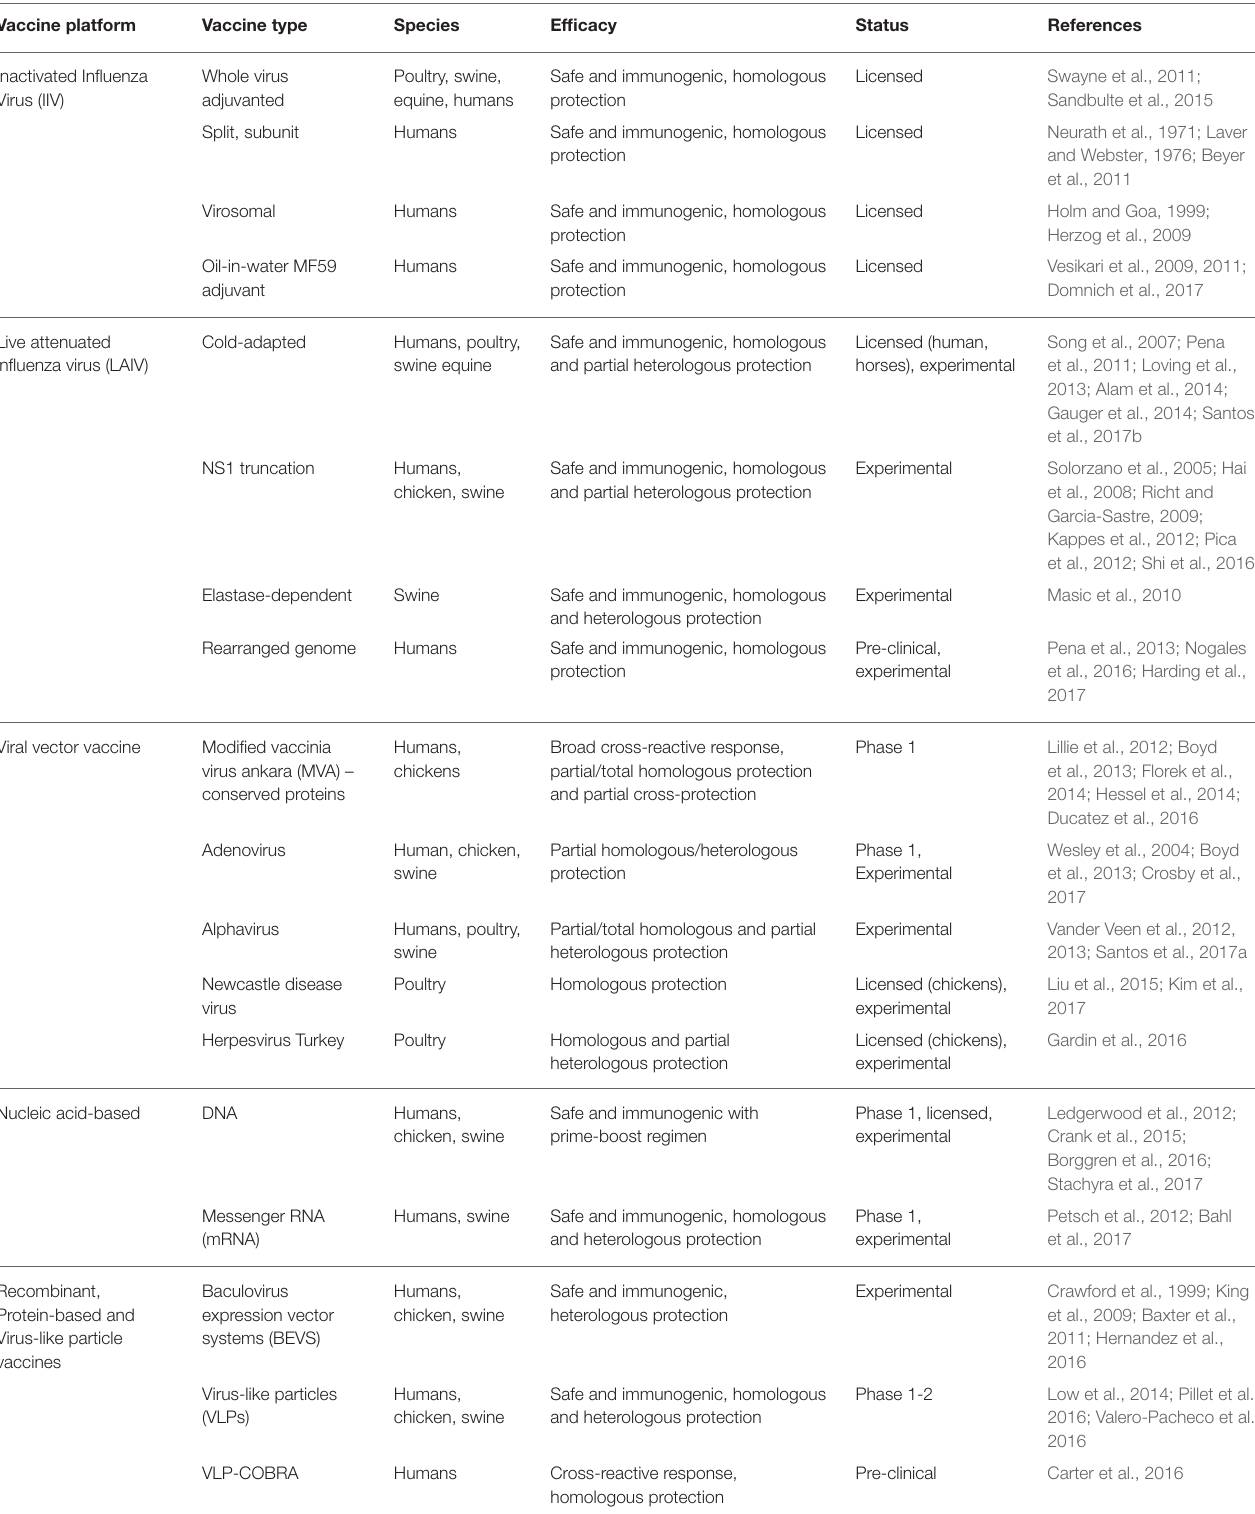
TABLE 1 | Summary of experimental and licensed vaccines against influenza viruses for humans and animals described in this review. Vaccine